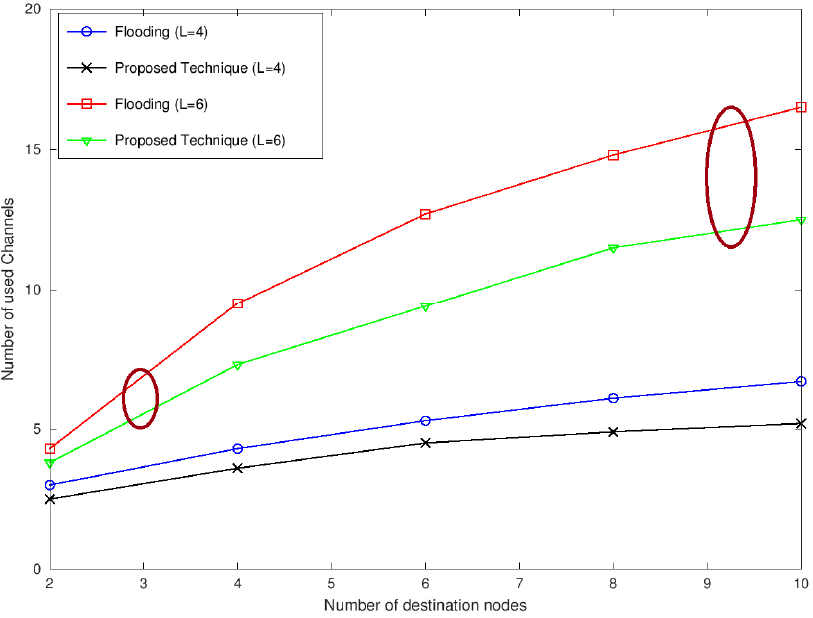
Figure 6. Average number of used channels versus the number of destination nodes.